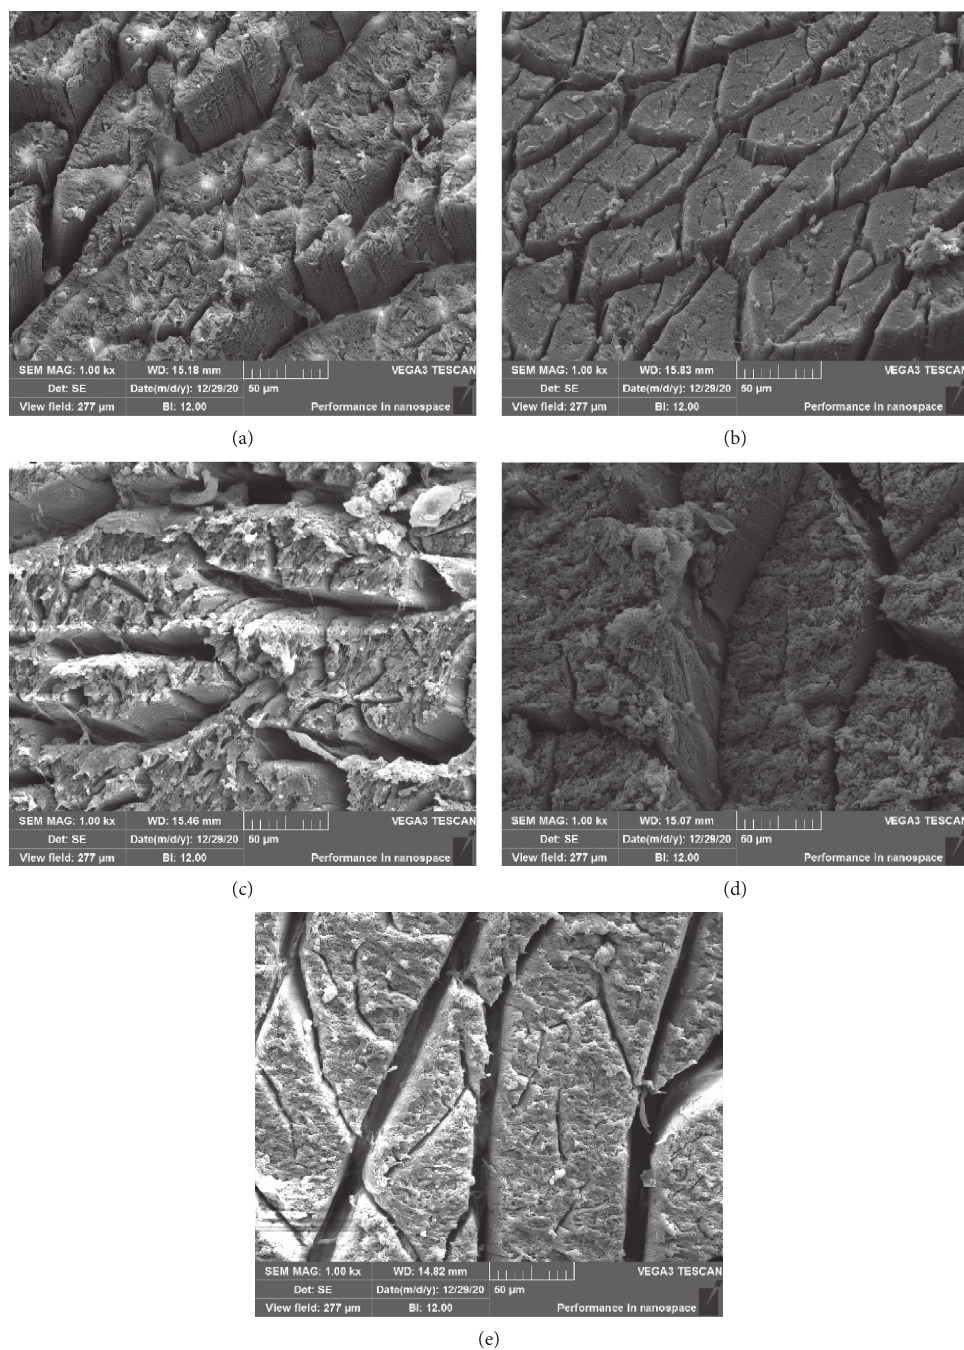
Figure 3: Influence of different packing methods and storage temperatures on the microstructure of dried shrimp muscle (magnification: 1000). (a) 0 day. (b) 30-day VP37 ° C. (c) 30-day AP37 ° C. (d) 30-day VP20 ° C. (e) 30-day AP20 °